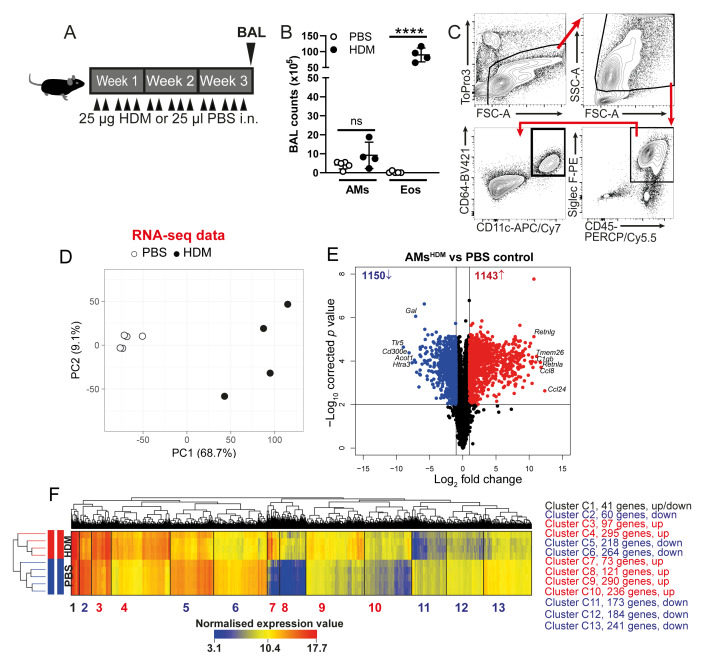
Identification and clustering of differentially expressed AM genes in the mouse HDM model.(
A) Schematic of the HDM AAD model, with arrows indicating individual intranasal challenges. (
B) Absolute counts of AMs and eosinophils (eos) in BAL as determined by flow cytometry. Means, standard deviations and individual replicate values are shown. (
C) Gating strategy for flow cytometry sorting of total AMs from BAL. Representative plots from a HDM-treated mouse are shown. (
D) Principal component analysis based on all genes (filtered on minimum expression) in AMs
HDM and control AMs from PBS-treated mice. (
E) Volcano plot showing the results of differential expression analysis. (
F) Hierarchical clustering or differentially expressed genes with major clusters (3
rd tier of dendrogram) highlighted. Cluster characteristics are shown to the right. N=5 mice, PBS; N=4 mice, HDM.